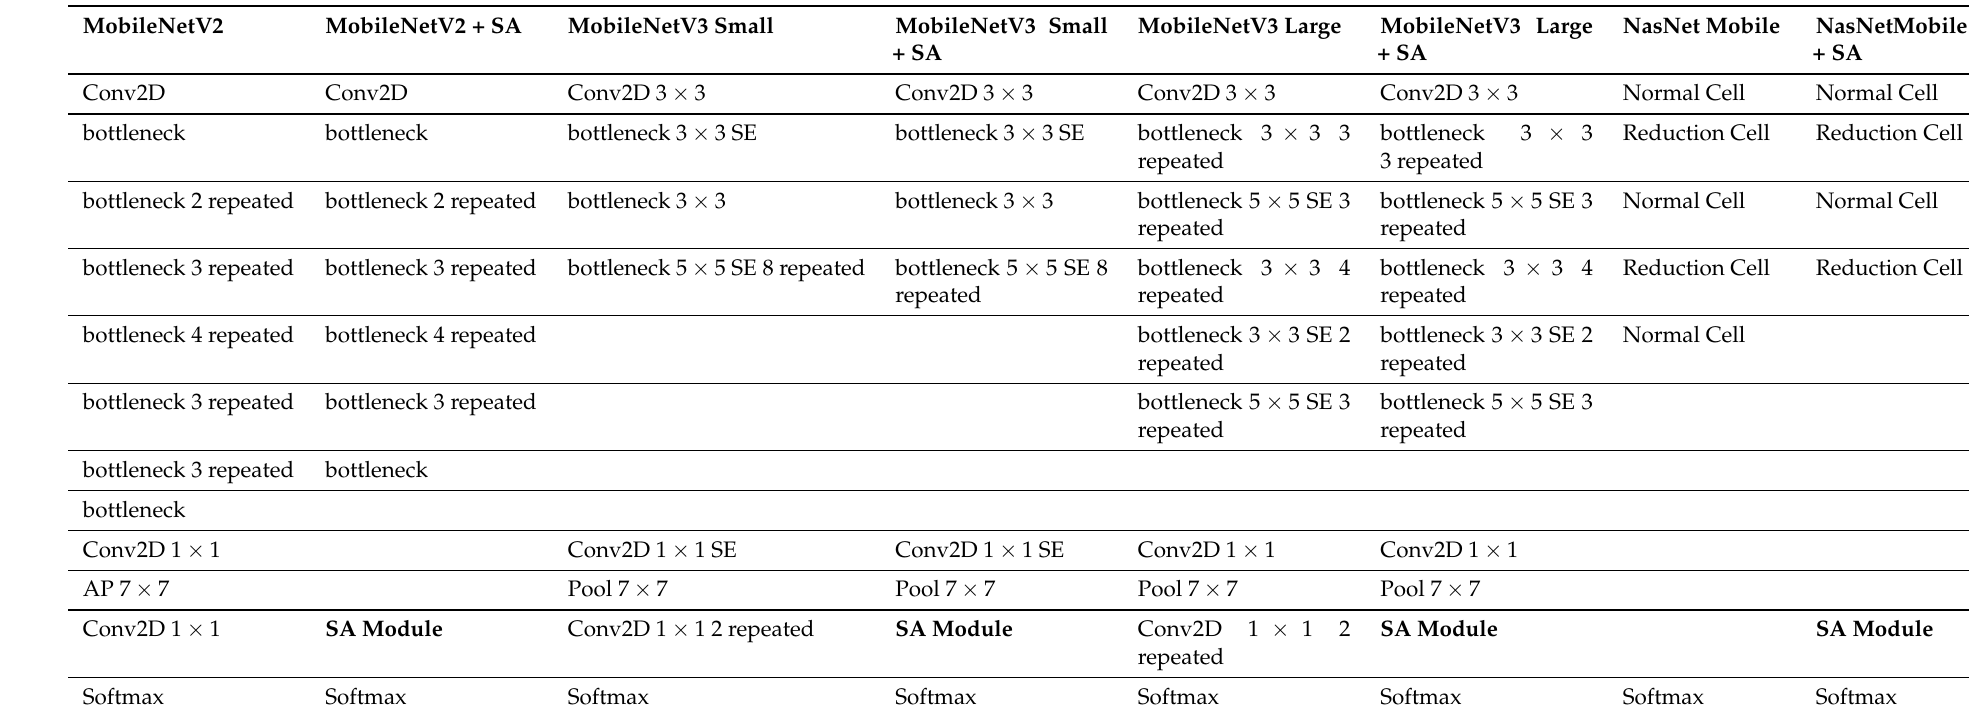
Table A2. Detailed structure of mobile-based models. SA stands for Soft-Attention, SA Module denotes whether that model uses the Soft-Attention